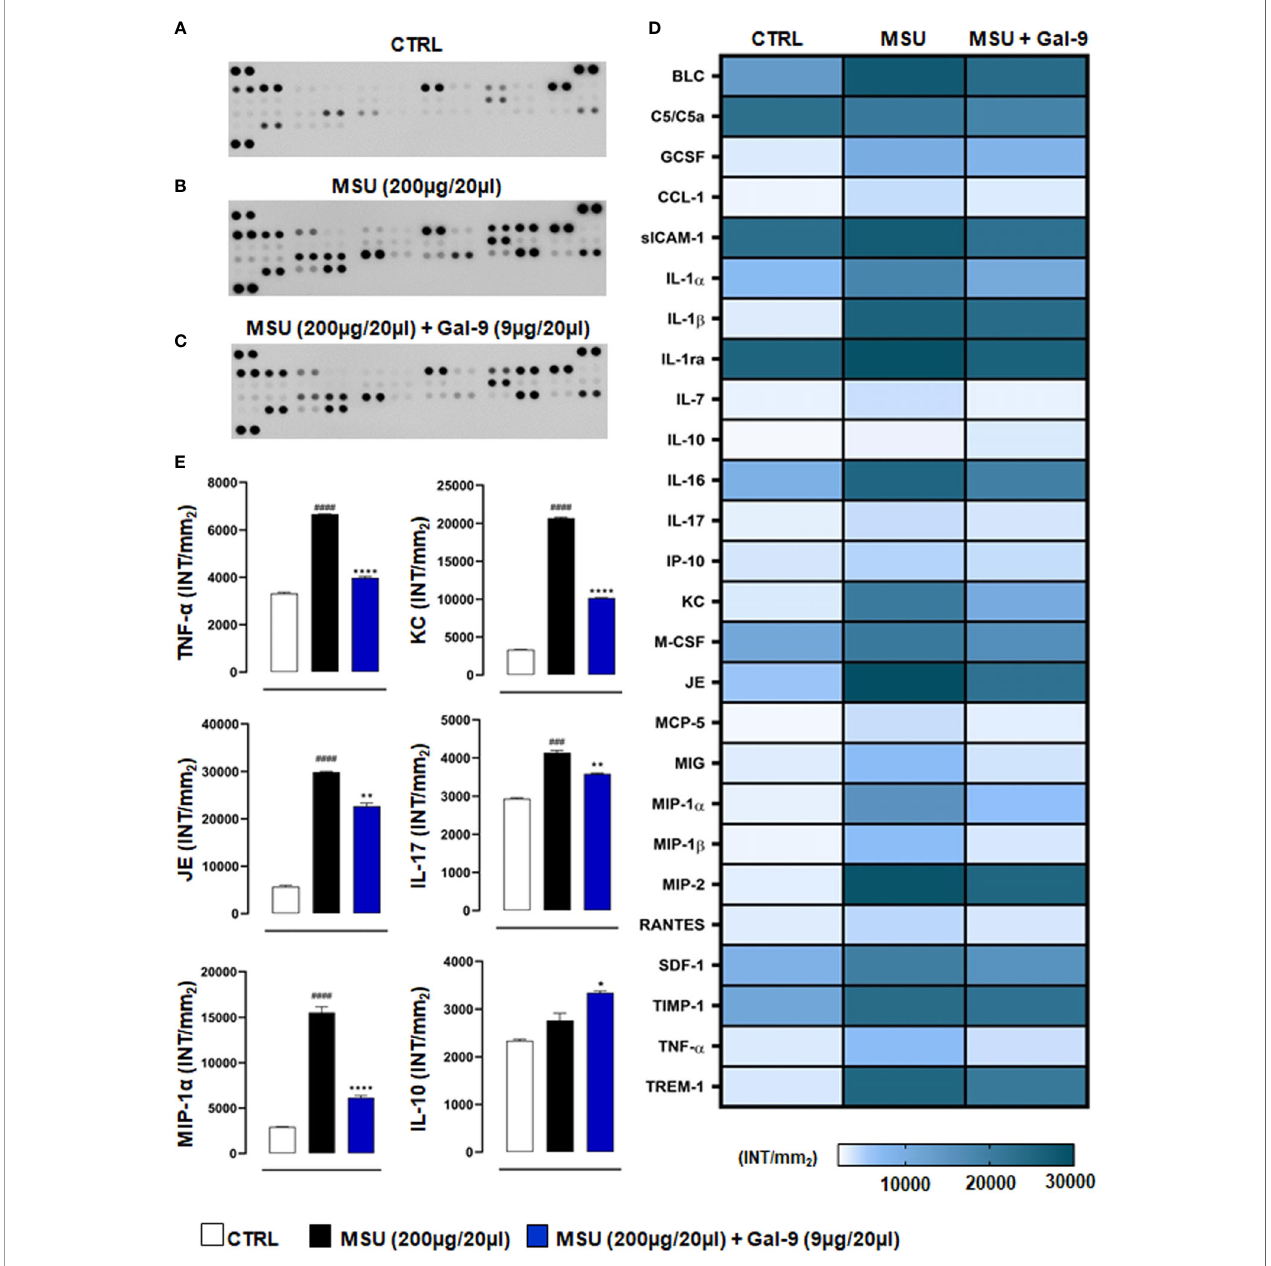
FIGURE 4 | Gal-9 decreases the release of cyto-chemokines in knee joints. In fl ammatory fl uids obtained from knee joint homogenates at 18h time-point, were assayed using a proteome pro fi ler cytokine array for (A) CTRL, (B) MSU and (C) MSU + Gal-9 group. Densitometric analysis is presented as heatmap (D) . Thereafter, IL-10, IL-17, KC, JE, MIP-1 a and TNF- a were extrapolated from heatmap and represented graphically (E) . Data (expressed as INT/mm 2 ) are presented as means ± SEM. of positive spots of three separate independent experiments run each with n = 6 mice per group pooled. Statistical analysis was performed by using two-way ANOVA followed by Bonferroni ’ s test for multiple comparisons. ### P ≤ 0.001, #### P ≤ 0.0001 vs Ctrl group; *P ≤ 0.05, **P ≤ 0.01, ****P ≤ 0.0001 vs MSU